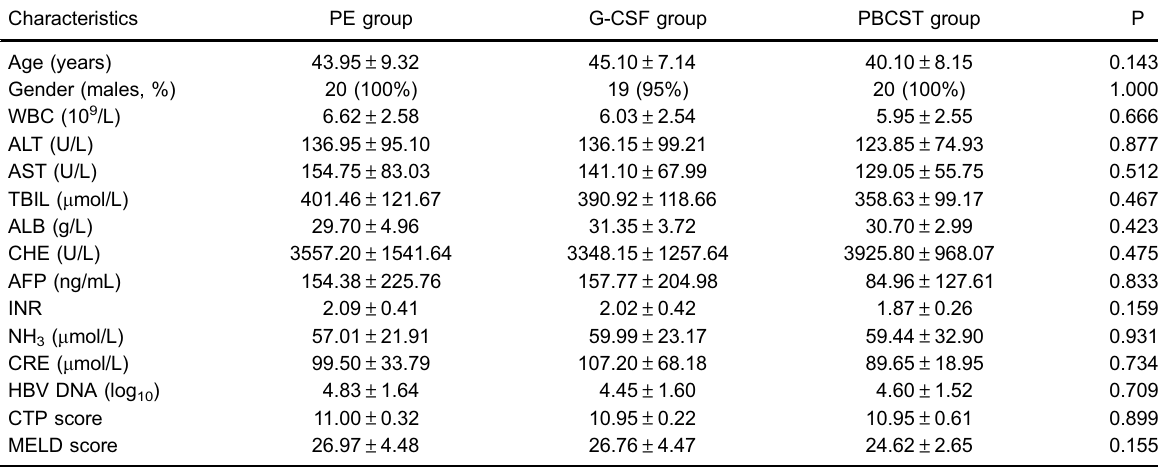
Table 1. Baseline characteristics of patients in the study population (n=20/group).